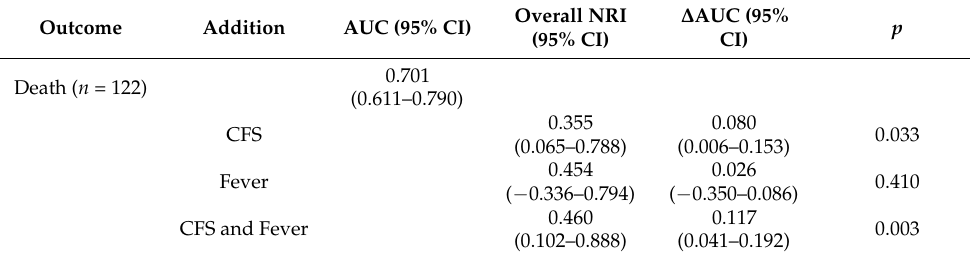
Table 3. Accuracy of the CXR score and net reclassification analysis for death during hospitalization.